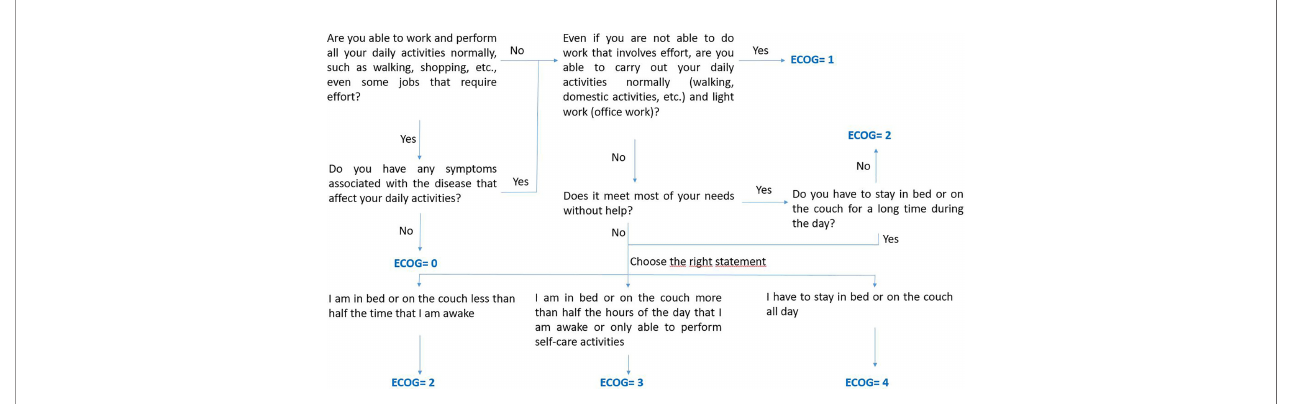
FIGURE 1 | Algorithm de fi ned by the study investigators to guide healthcare professionals on the questions to ask patient to calculate the